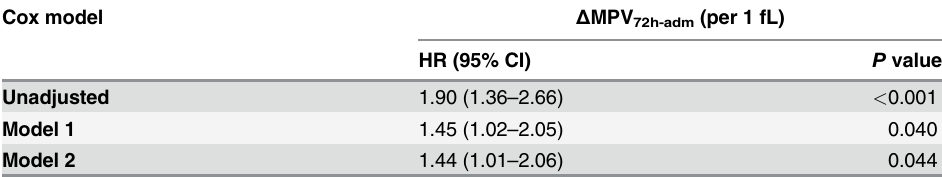
Model 1: adjusted for age, sex, body mass index, Sequential Organ Failure Assessment score, renal replacement therapy, platelet count, C-reactive protein level, albumin level, and lactate level. Model 2: model 1 plus adjustment for infection